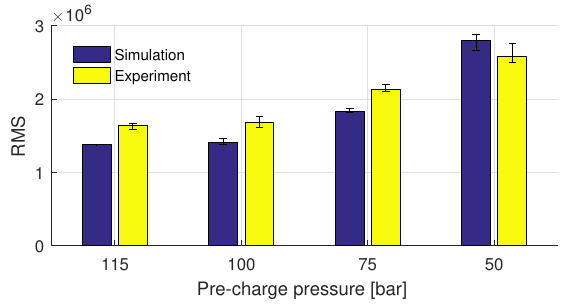
Figure 13. Mean value of the detail coefficient RMS decomposition Level 9 using simulation and experimental data. The error bars indicate the full range of RMS